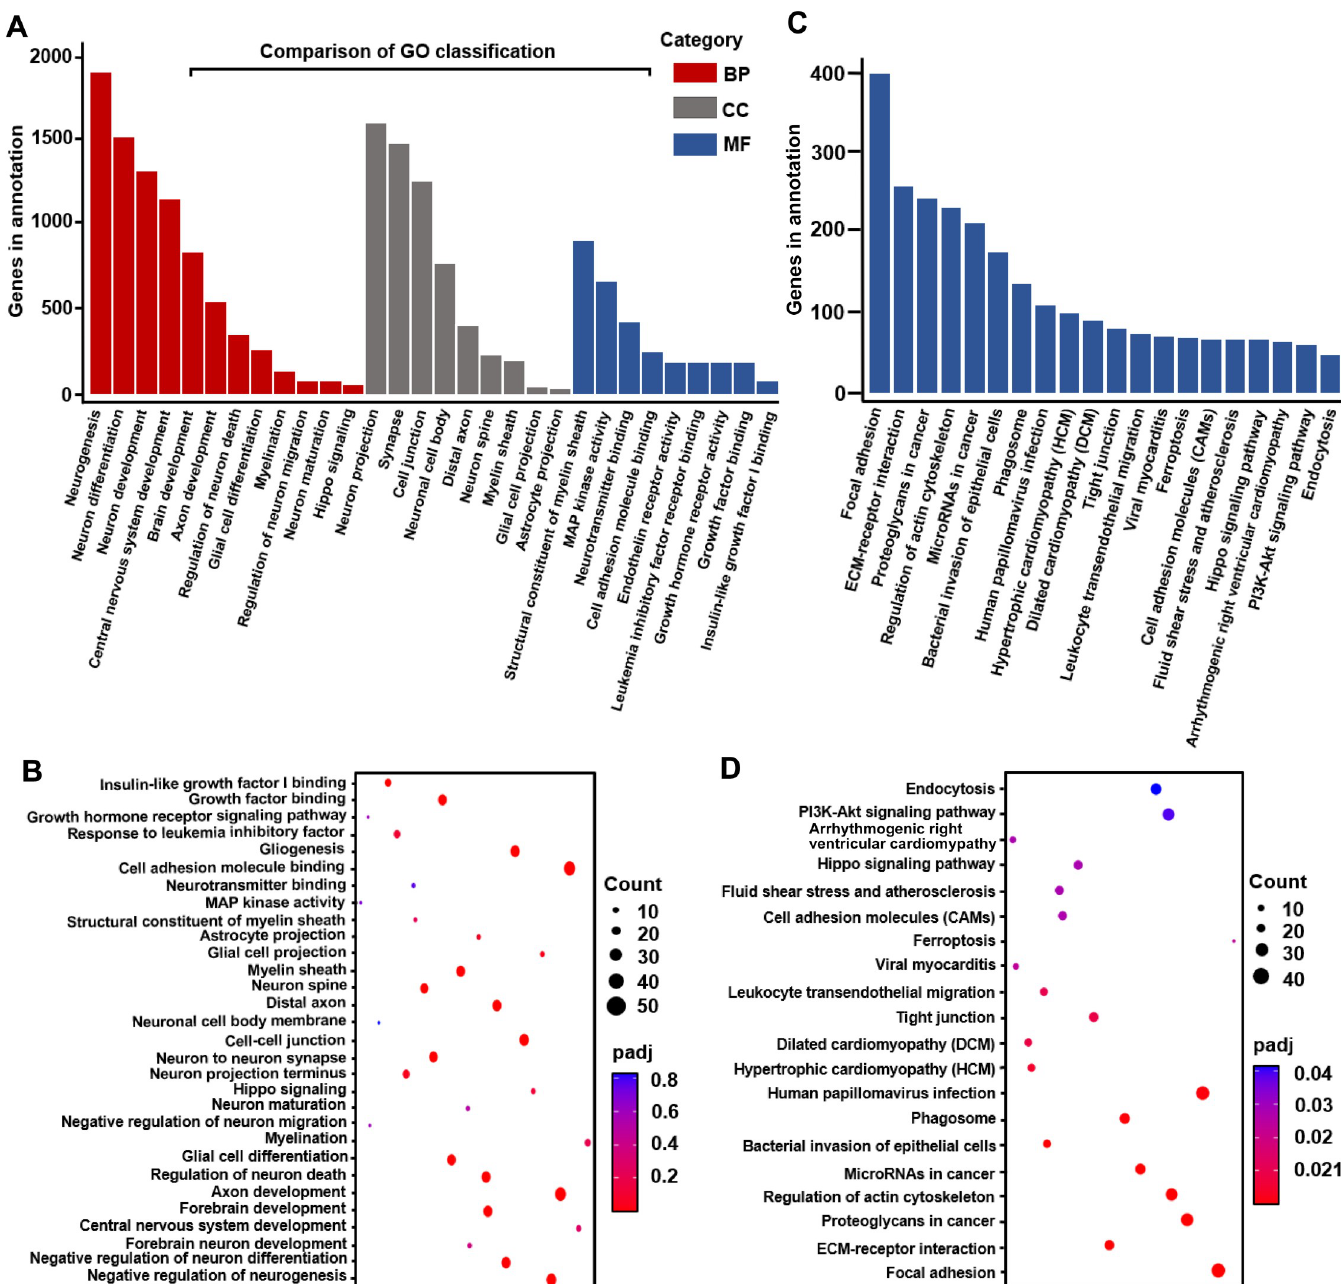
Fig 3. Functional categorization of the differentially expressed genes (DEGs) in ZIKV-infected MPAs. (A) The DEGs were assigned to three gene ontology classes: biological process (BP, red color), cellular component (CC, dark grey color), and molecular function (MF, blue color), with top 30 functional terms. (B) The dot plot displays the enrichment score values of the top 30 most significant enrichment terms. (C) Pathway enrichment (top 20) involved in significant genes reported in ZIKV- infected relative to Mock mouse primary astrocyte cells from RNA-seq analysis. KEGG was used as the pathway database. Enrichment scores are based on (A). (D) Top 20 enriched KEGG pathways among the annotated DEGs in 2 groups comparisons. The Y-axis represents KEGG pathways. Low padj values are shown in red, and high padj values are depicted in blue. Pathways with padj values less than 0.05 are significantly enriched. The size of the spot reflects the number of DEGs, and the color of the spot corresponds to different padj-value ranges. The underlying numerical data for “Fig 3A, 3B, 3C, and 3D” is provided in the supporting file “S1 Data”.